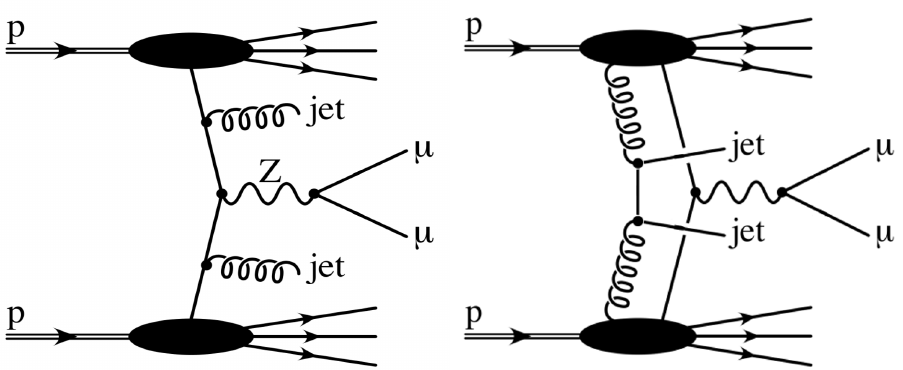
Figure 1 . Typical diagrams for Z + 2 jet production in a single (left) and double-parton (right) scattering